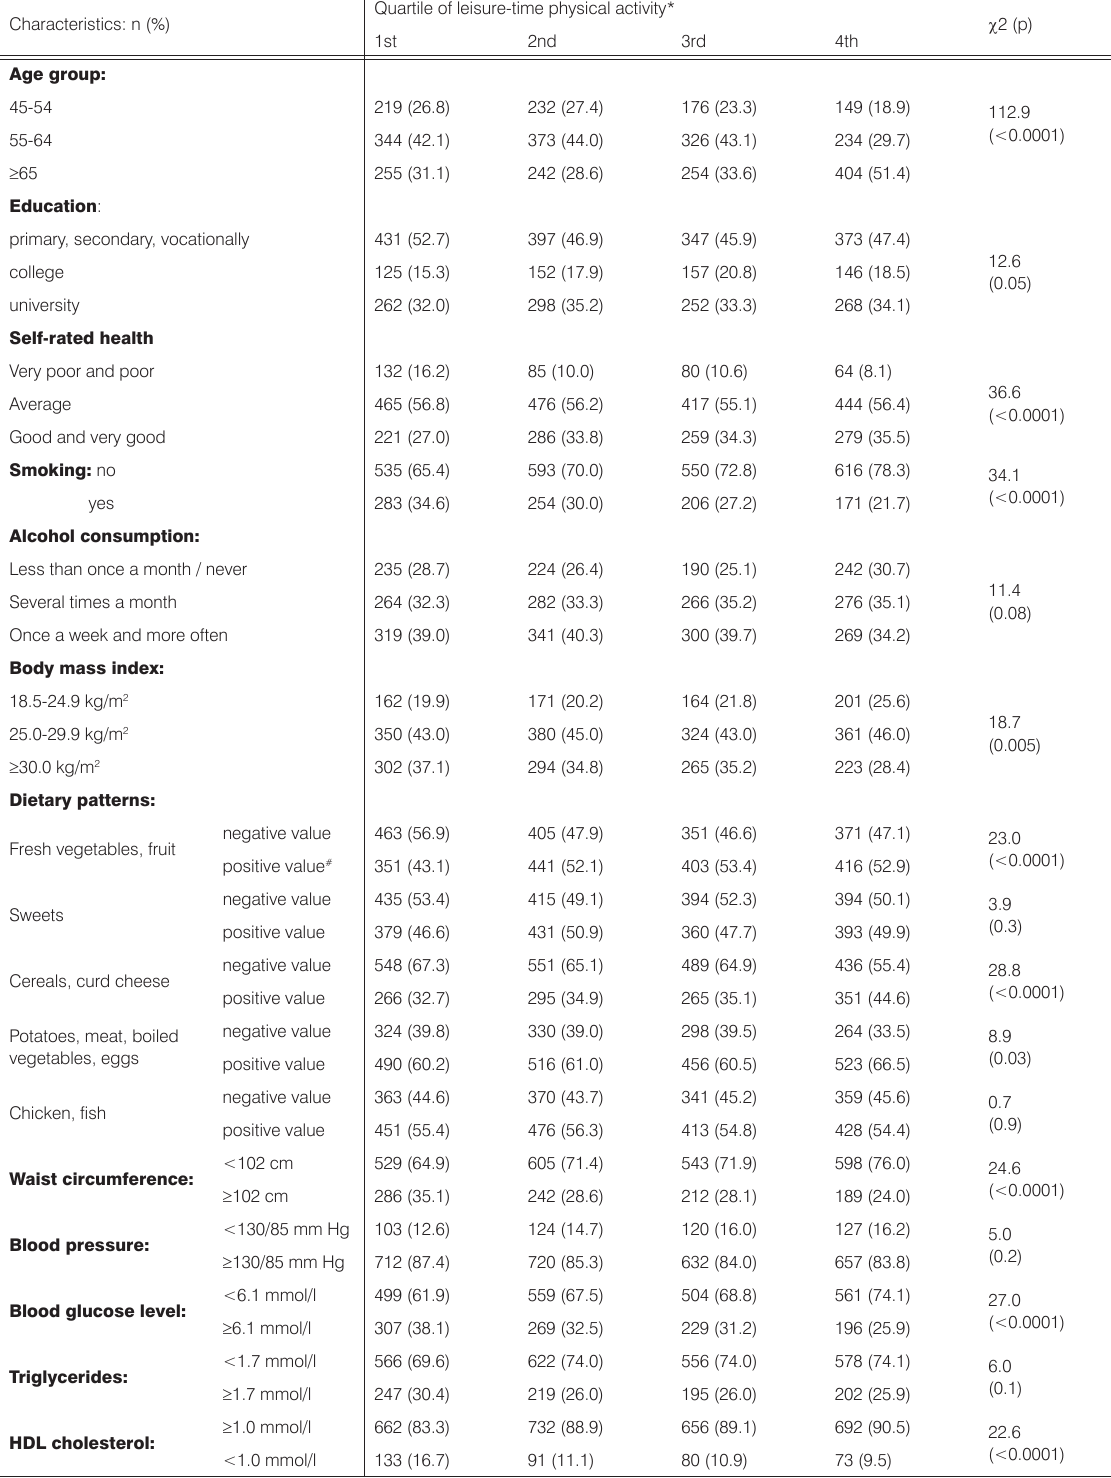
Table 1. Characteristics according to leisure-time physical activity level in middle- and older-aged men Characteristics: n